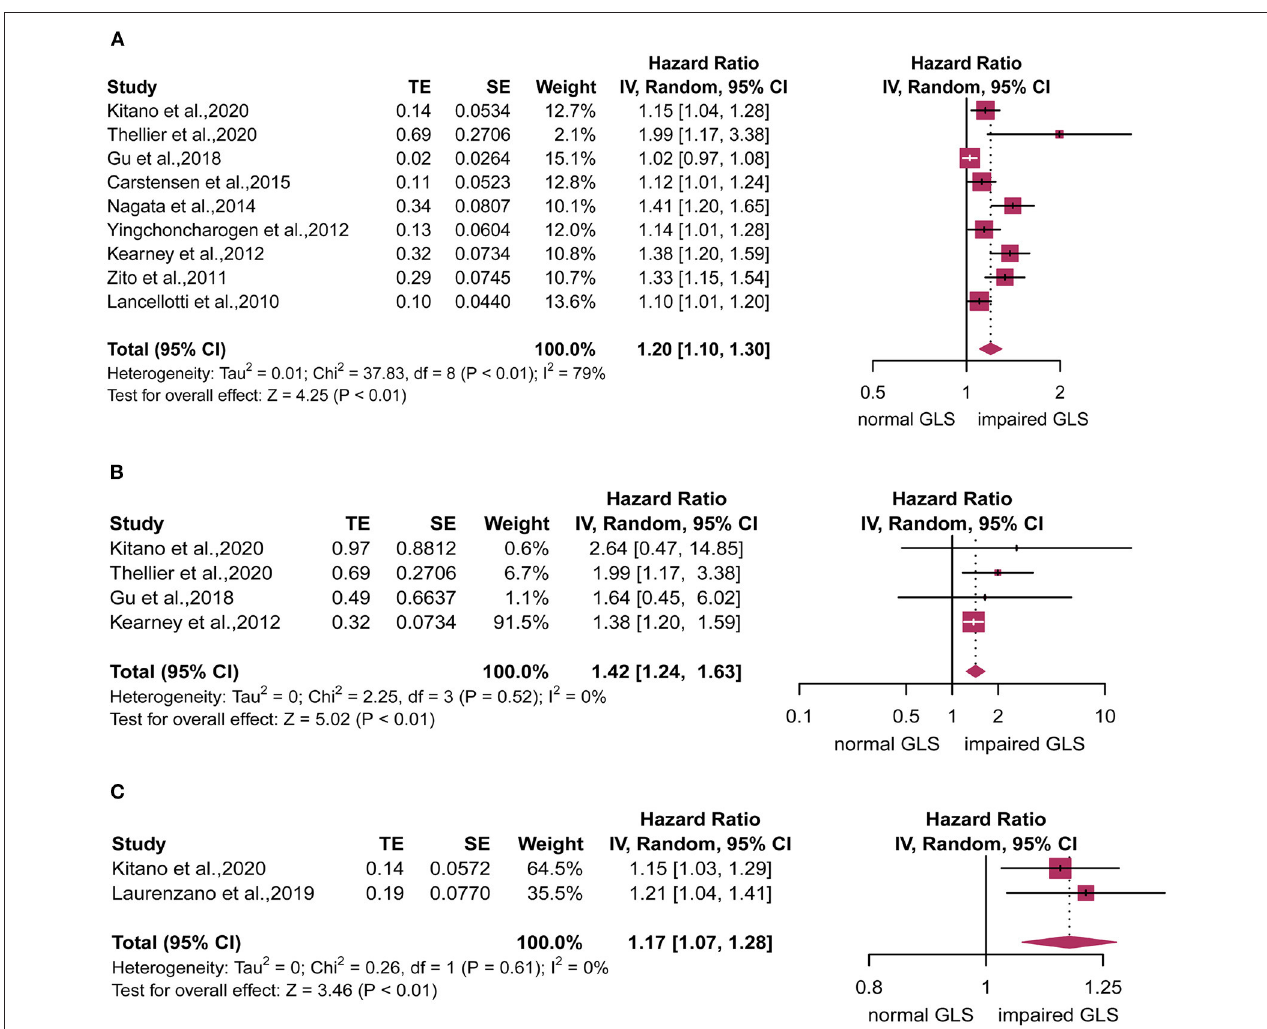
FIGURE 2 | Forest plot for the association between impaired global longitudinal strain (GLS) and (A) major adverse cardiovascular events (MACE), (B) all-cause mortality, or (C) aortic valve replacement